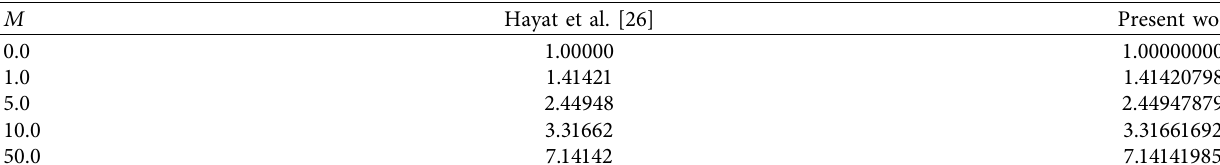
Table 1: Comparison of Cf 1/2 with the results of Hayat et al. [26] when α � λ � 0 and β ⟶ ∞ . x Re